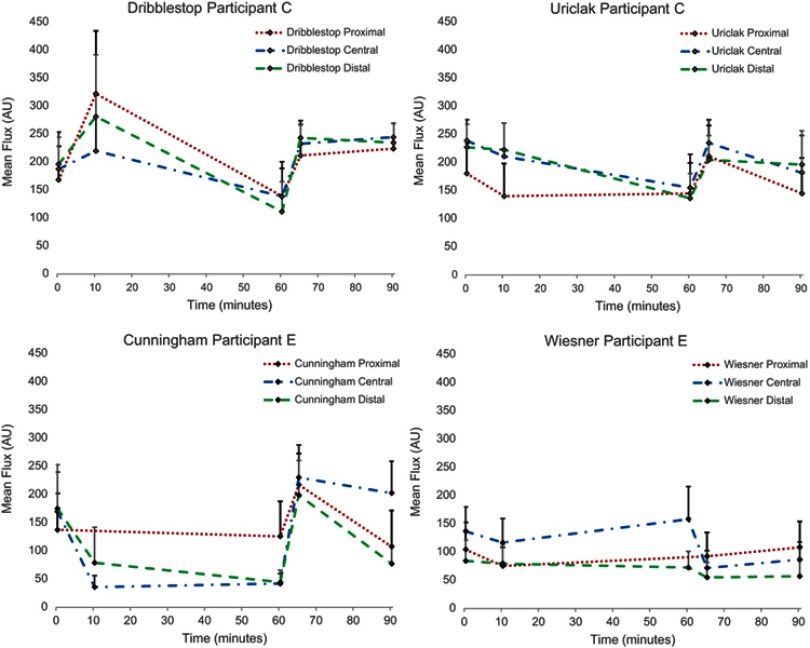
Temporal profiles of Doppler ROI values in three regions of the penis of two participants for each of the penile compression device (PCD) designs. Error bars represent perfusion flux SD.